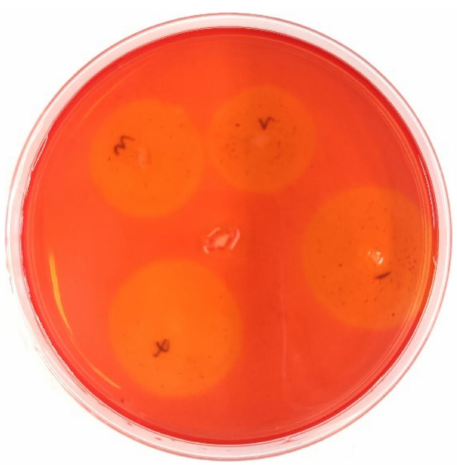
Figure 7. Transparent circles formed by cellulase-producing bacteria isolated from the control group. Around the plate are cellulase-producing bacteria and in the middle are Escherichia coli DH5- α